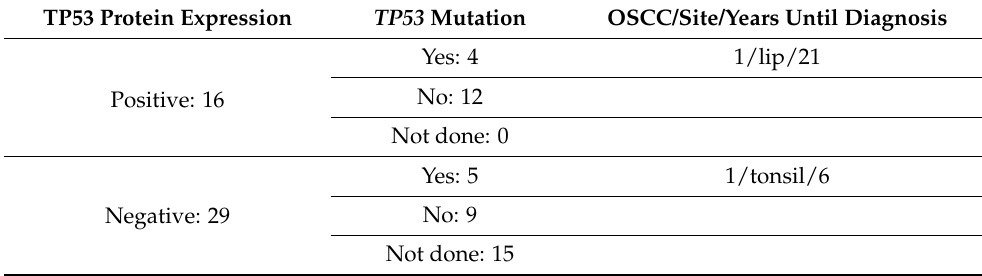
Table 1. Follow-up of patients with Oral lichen planus related to TP53 protein expression and TP53 mutations. TP53 Protein